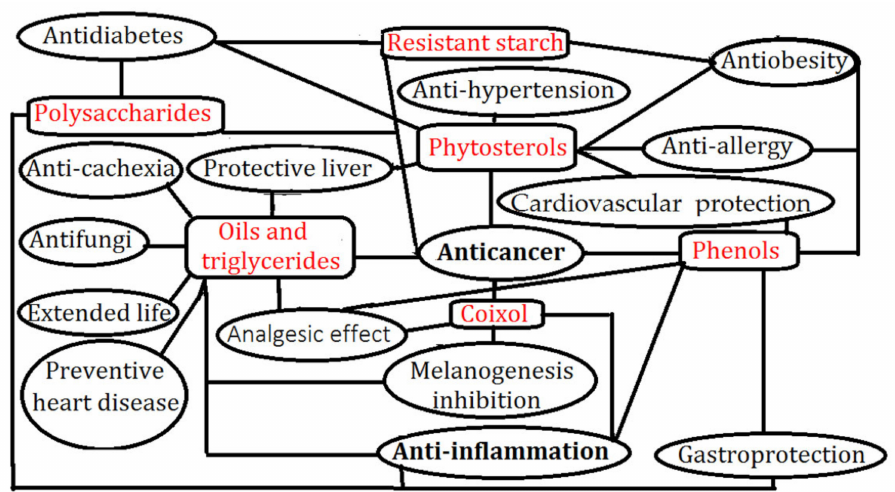
Figure 2. Actional relationship between functional components of adlay and chronic